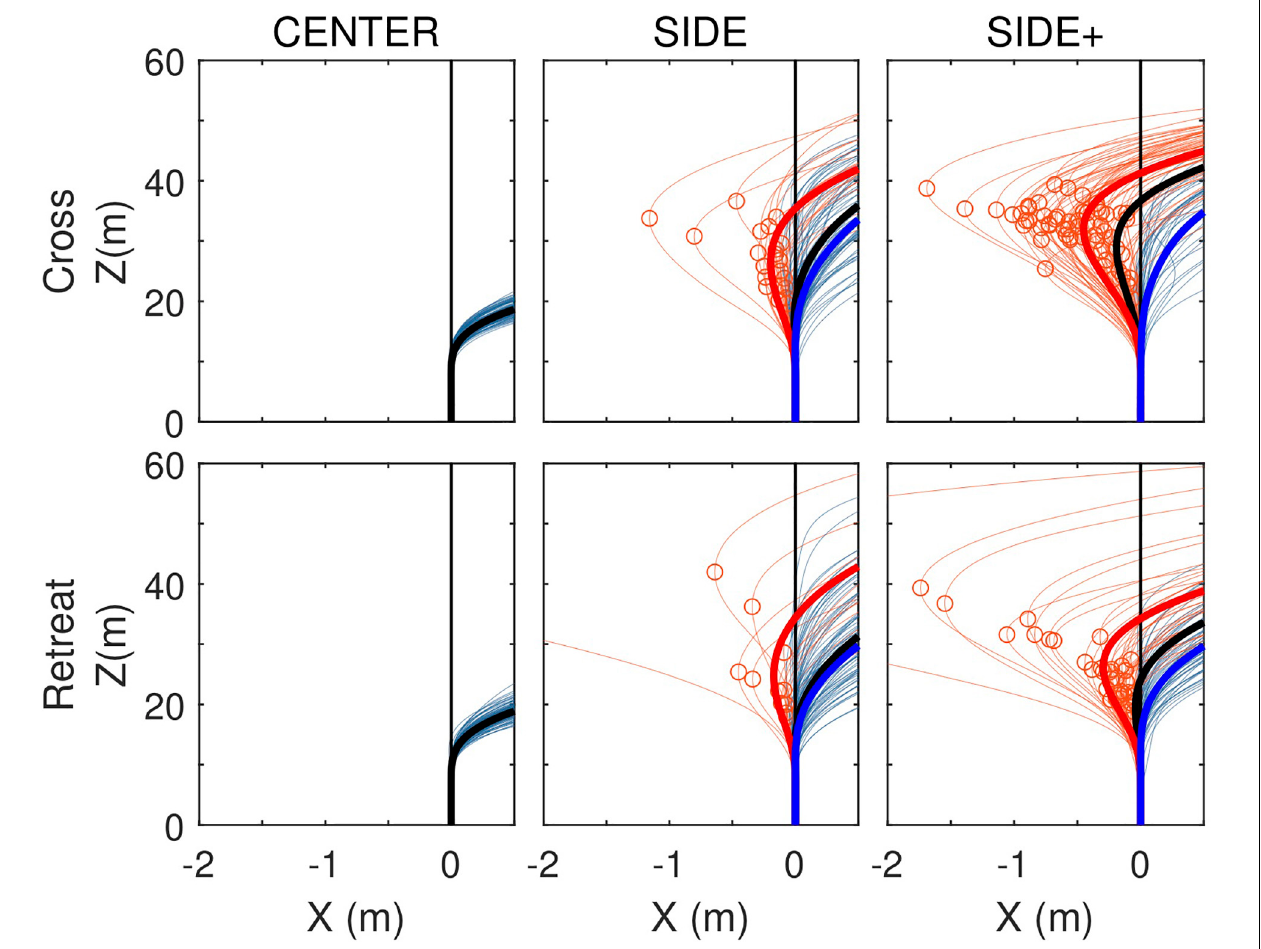
FIGURE 5 | Locomotor paths for individual trials (thin lines) under the CENTER, SIDE, and SIDE+ eccentricity conditions for the Cross and Retreat target directions. Trials with a reversal in movement direction (RMD trials) are depicted in light red and trials without a reversal in movement direction (NoRMD trials) in light blue. Red circles indicate pre-reversal excursion amplitudes. Fat lines represent time-averaged averaged locomotor paths for RMD trials (red), for NoRMD trials RMD (blue), and for all trials